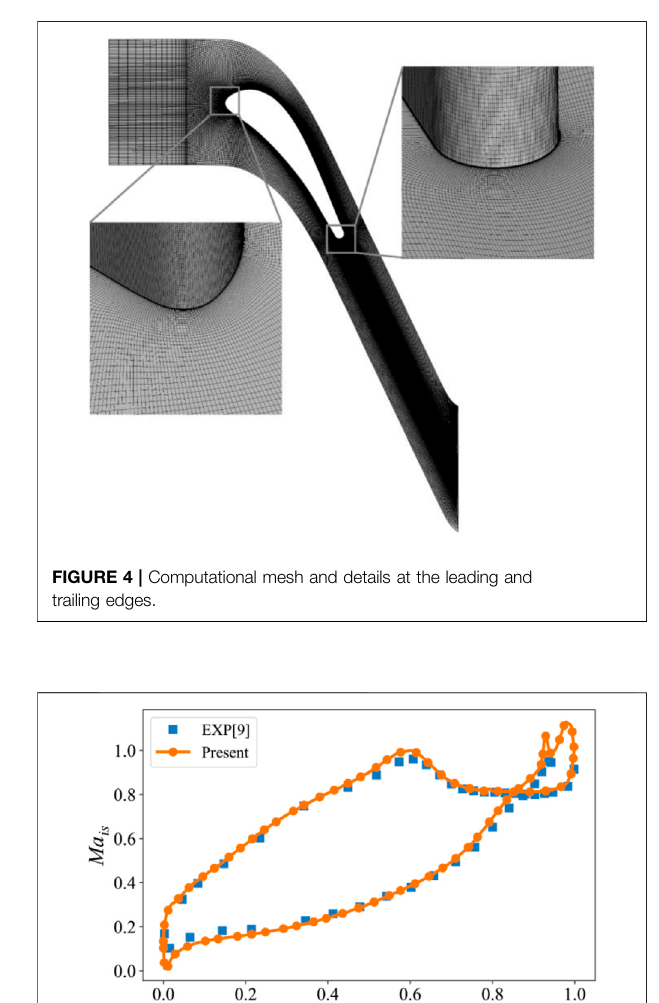
FIGURE 5 | Time-averaged isentropic Mach